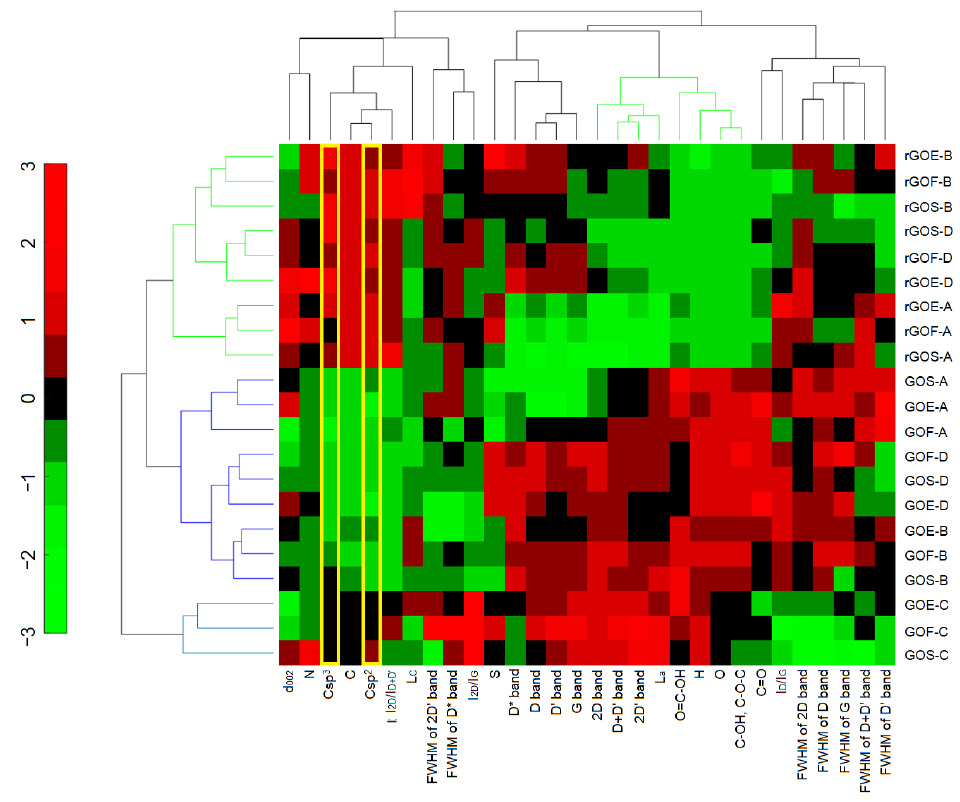
Figure 8. The clustered heat map for the studied GO and rGO samples and their properties.